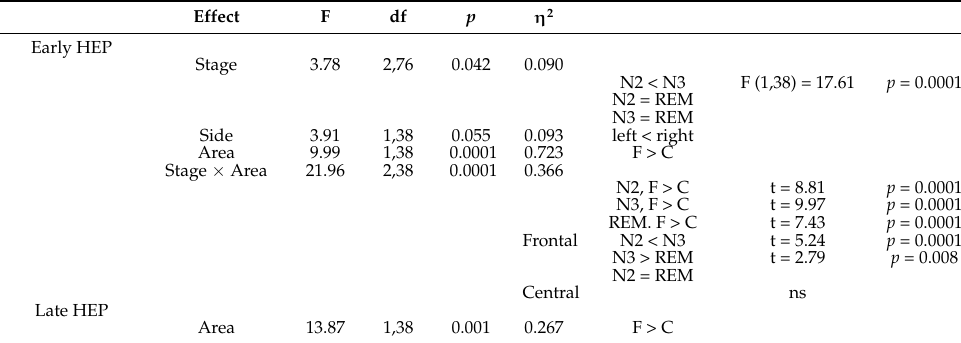
Table 2. HEP amplitude; ANOVA.